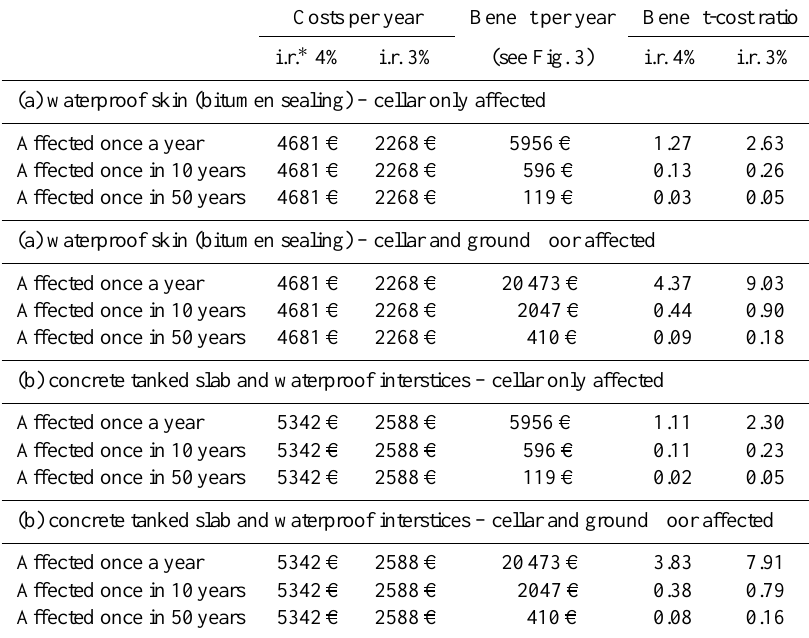
Table 4. Benefit-cost ratios for the construction of waterproof, sealed cellar walls using tanking: (a) constructions with a waterproof skin (bitumen sealing); (b) waterproof concrete tanking with concrete tanked slab and waterproof